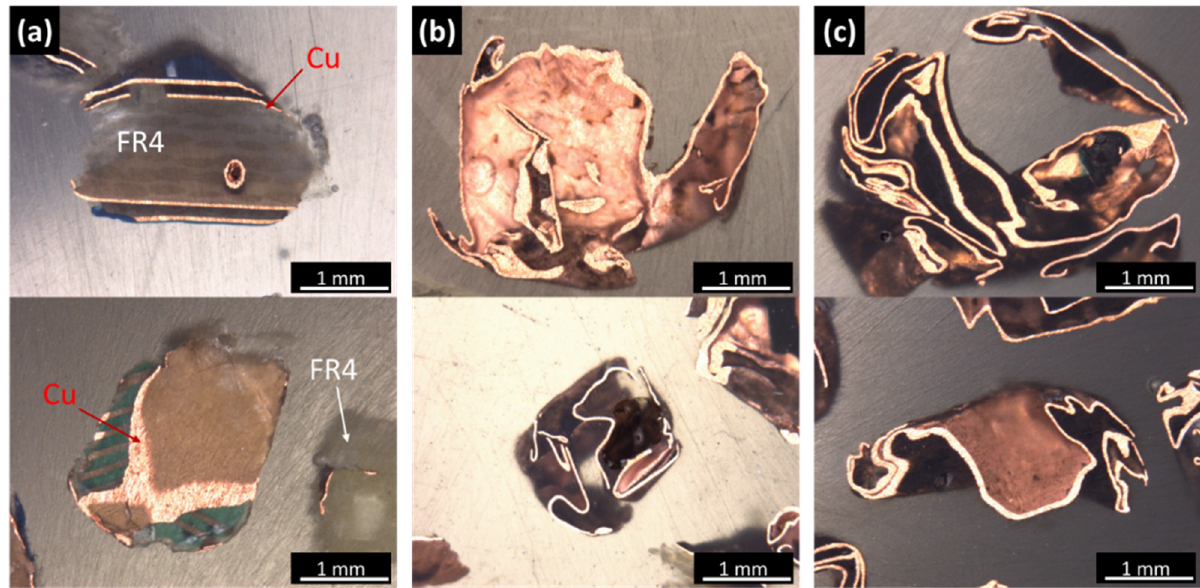
Figure 6. SEM images of the crushed PCB particles in the range of − 4000 to +2800 μ m: ( a ) nontreated raw, ( b ) 300 °C in air, and ( c ) 300 °C in nitrogen.